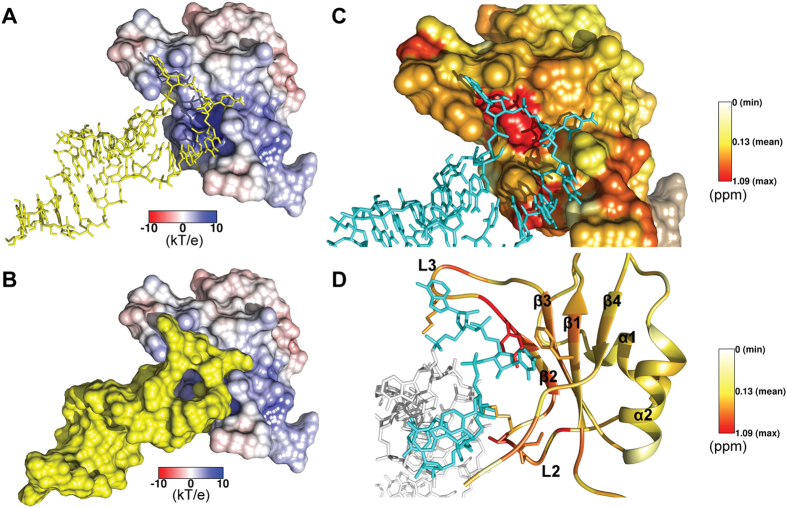
Structural model of TAF15-RRM-SON stem-loop RNA complex.The High Ambiguity Driven Protein-Protein Docking (HADDOCK) generated model using NMR structure of TAF15RRM (PDB 2MMY) was refined with molecular dynamics simulation (MD) in GROMACS with AMBER99SB-ILDN force field (A) Stick and (B) surface representations of RNA (yellow) on electrostatic surface of TAF15-RRM showing a positively charged (blue) cavity. (C) Surface and (D) ribbon representations of TAF15-RRM with CSP values mapped on residues, in complex with RNA (cyan). RNA binding is predominantly across the L2-β2-L3 interface as opposed to the entire β-sheet.